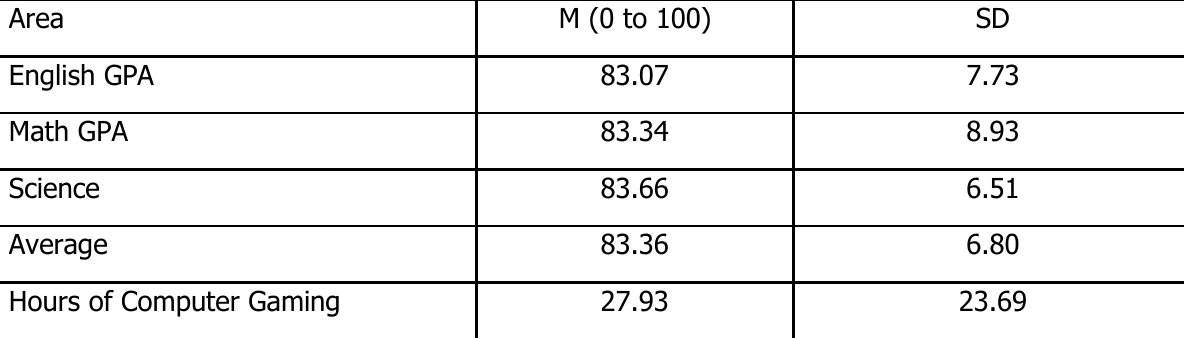
Descriptive Statistics for Subject Areas and Hours of Game Playing